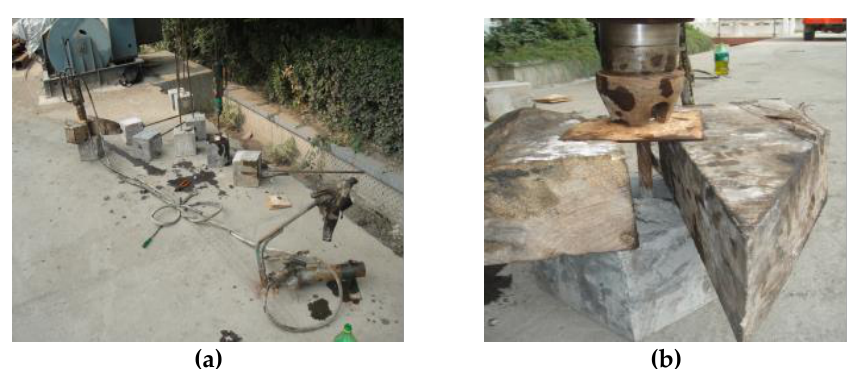
Figure 9. Adhesion stress test: (a) equipment installation ;(b) test pieces of loading.